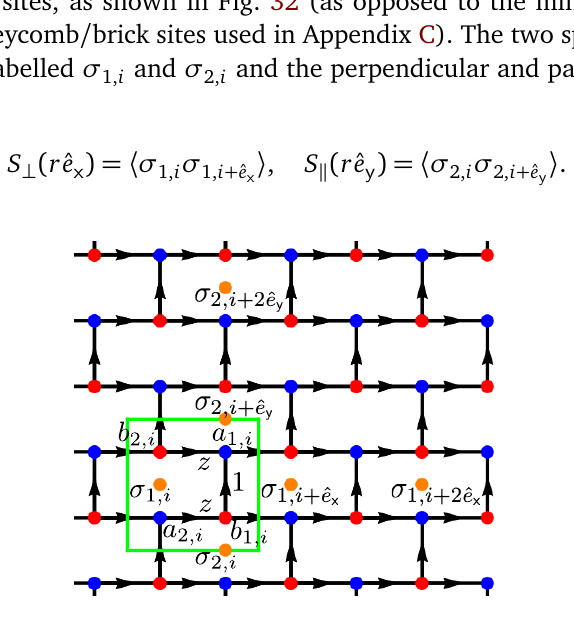
and σ , as 1, i 2, i , b , a and b . Correlations between spins can be 1, i 1, i 2, i 2, i